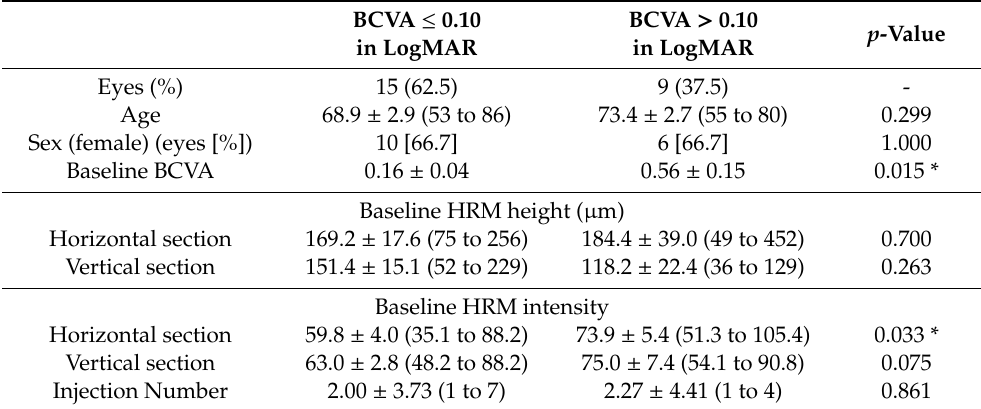
Table 2. Data in the patients with or without a visual outcome better than 0.10 in LogMAR at month 12.